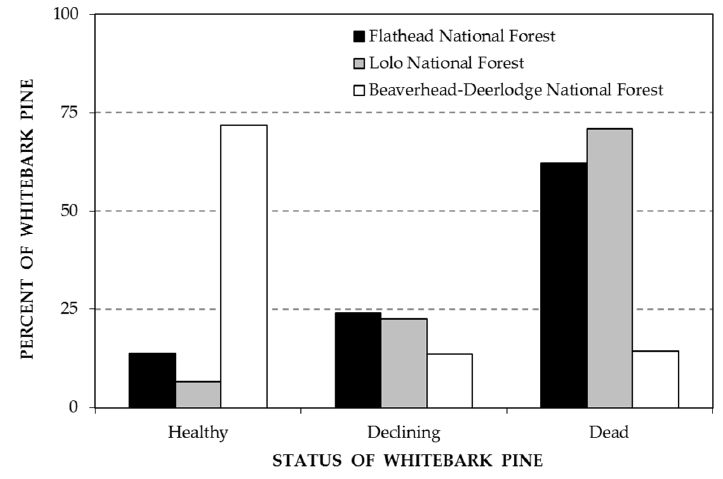
Figure 2. Comparing the health status of whitebark pine populations between national forests in western Montana. The Flathead National Forest is furthest north, the Lolo National Forest is in the middle, and the Beaverhead-Deerlodge National Forest is furthest south in the western Montana transect.